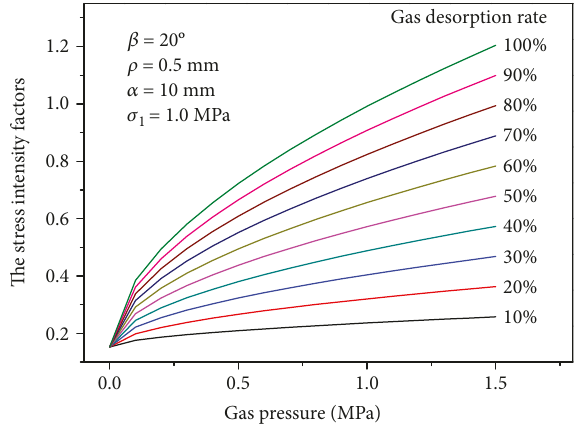
Figure 11: Sensitivity of incident gas desorption rate and gas pressure of gas-containing coal to K I